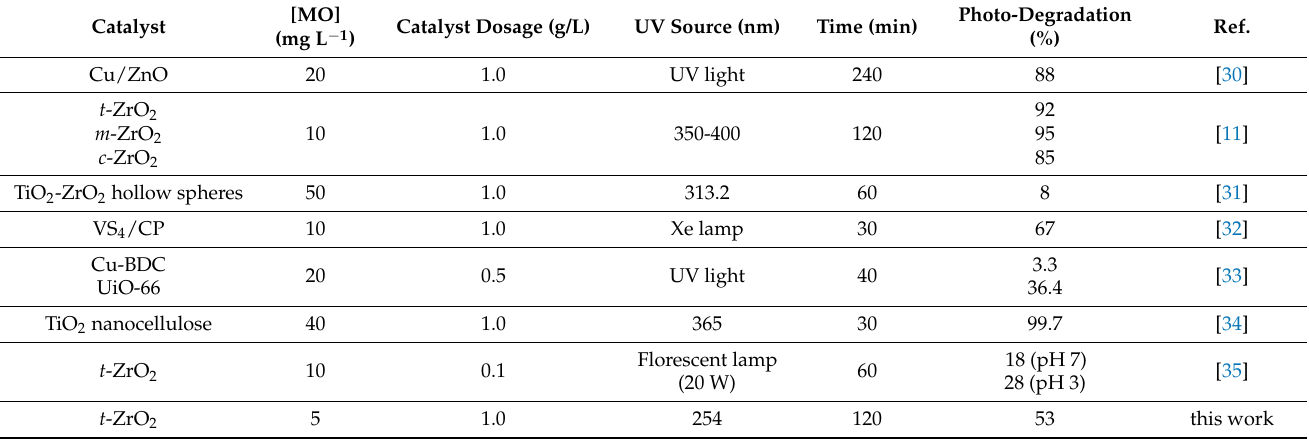
Table 5. Comparison of the present study with other reported photodegradations of methyl